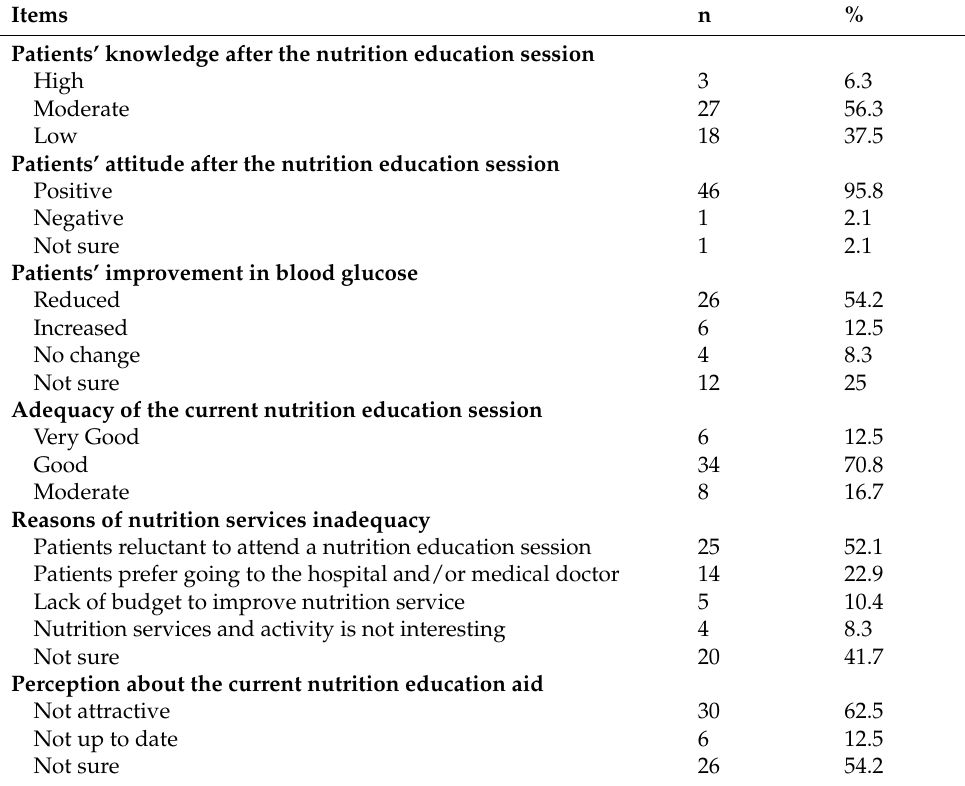
Table 3. Perception of nutritionists (n = 48) about the adequacy of the current nutrition services available for people with T2DM at the public health